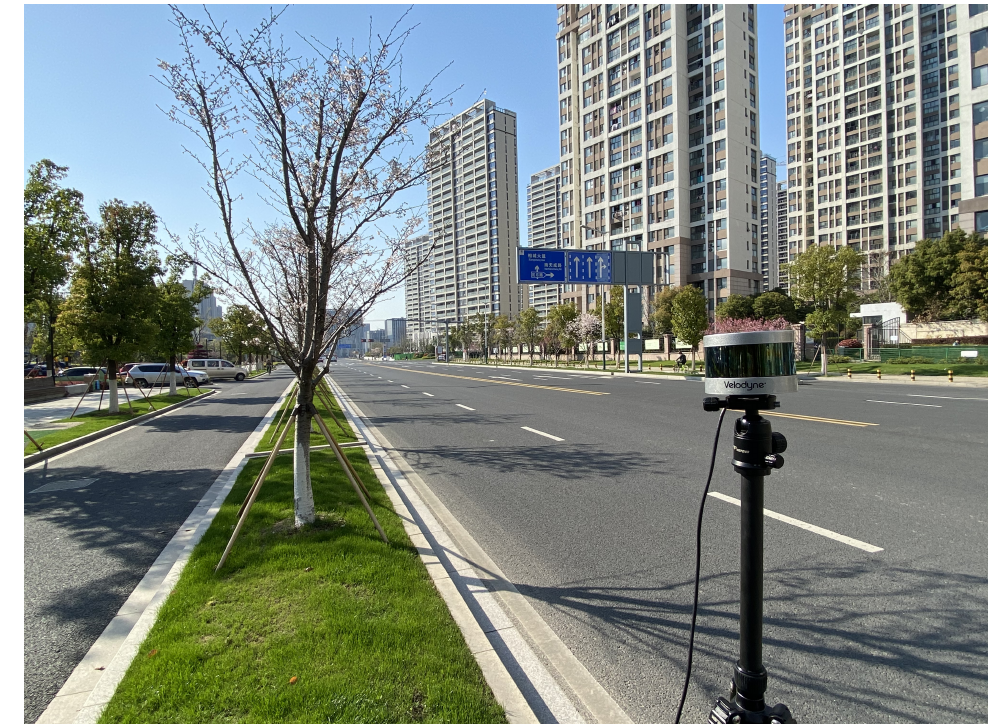
Figure 1. Roadside LiDAR and traffic